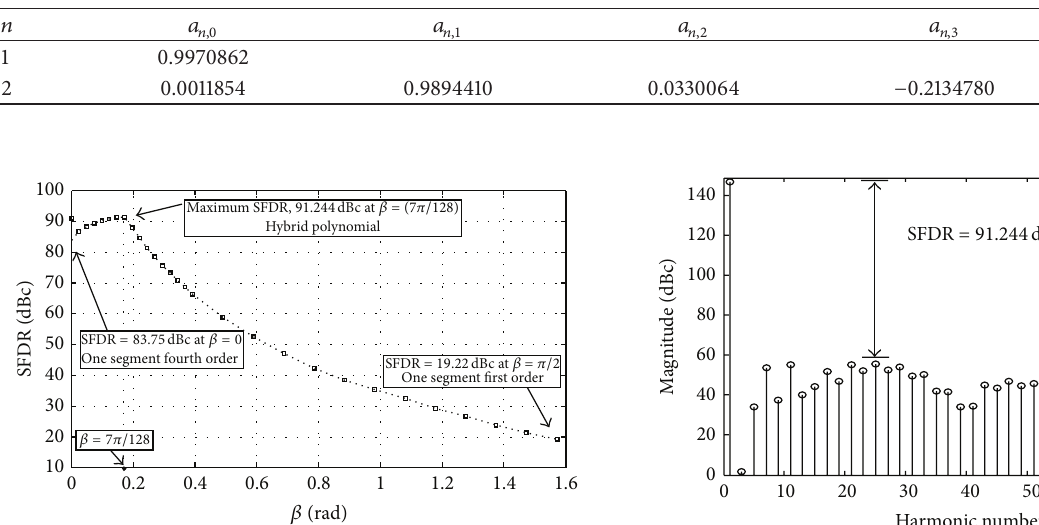
Table 1: Optimal polynomial coefficient.